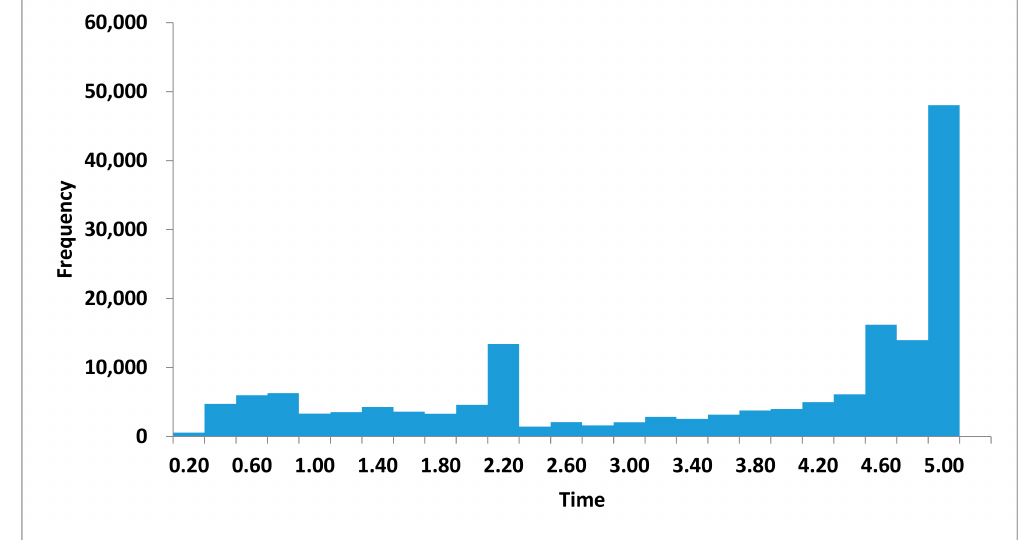
Figure 9. Exercise of the option to delay investment up to T = 5